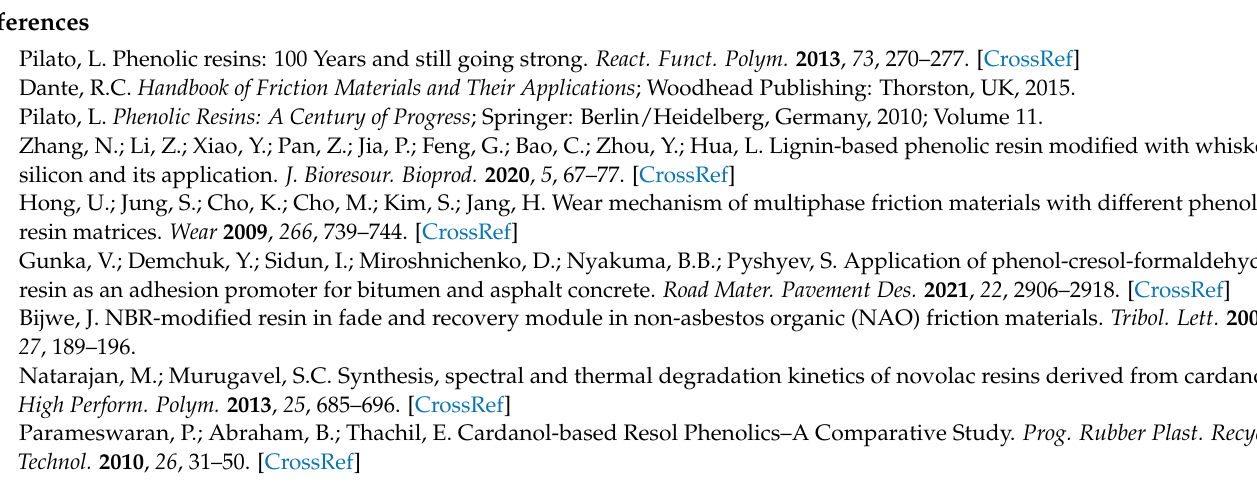
the parameters of Experiment 2. Figure S2: Chromatogram of sample B with the parameters of Experiment 8. Figure S3: Chromatogram of sample B1 with the parameters of Experiment 2. Figure S4: Chromatogram of sample C with the parameters of Experiment 2. Table S1: Experiments calculated by Chemometric Agile Tool software; where for acetone, dichloromethane, heptane +1 is yes, − 1 is no; for extraction +1 is sonication process, − 1 Soxhlet process; for time of GC analysis +1 is 30 min, − 1 is 24 min. Table S2 Compounds in sample A. Table S3: Compounds in sample A1. Table S4: Compounds in sample B. Table S5: Compounds in sample B1. Table S6: Compounds in sample C. Table S7: Compounds in sample C1. Table S8: Compounds in sample D. Table S9: Compounds in sample E. Table S10: Compounds in sample F. Table S11: Compounds in sample W. Table S12: Compounds in sample X. Table S13: Compounds in sample